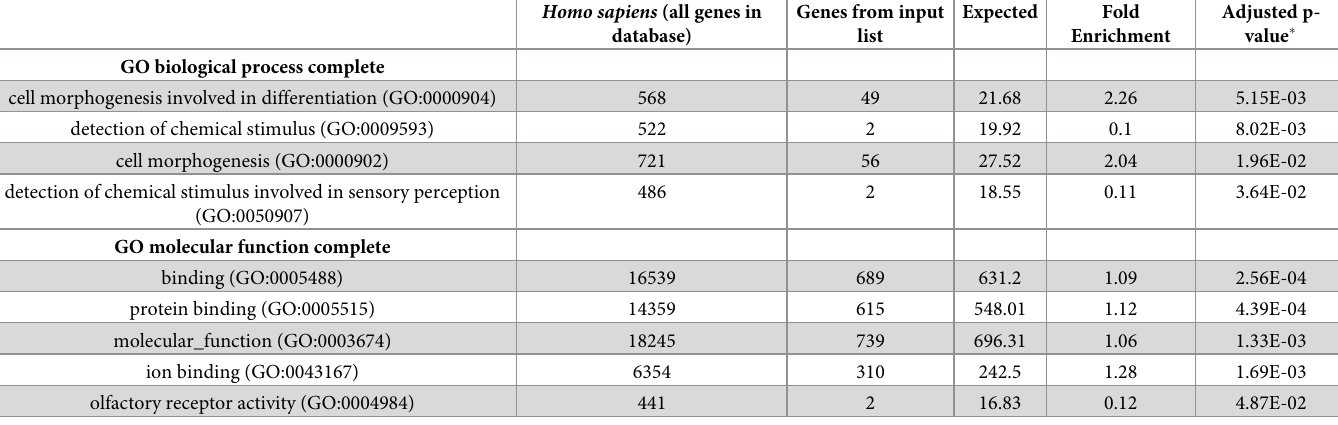
Table 6. Bioinformatic functional assessment of less methylated AHC profile DMRs via PantherDB.